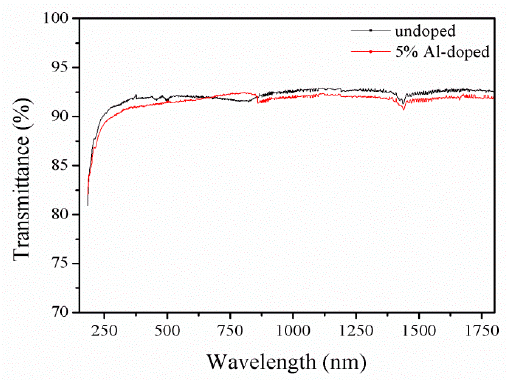
Figure 4. Transmission spectrum of undoped and Al-doped CLBO crystals.